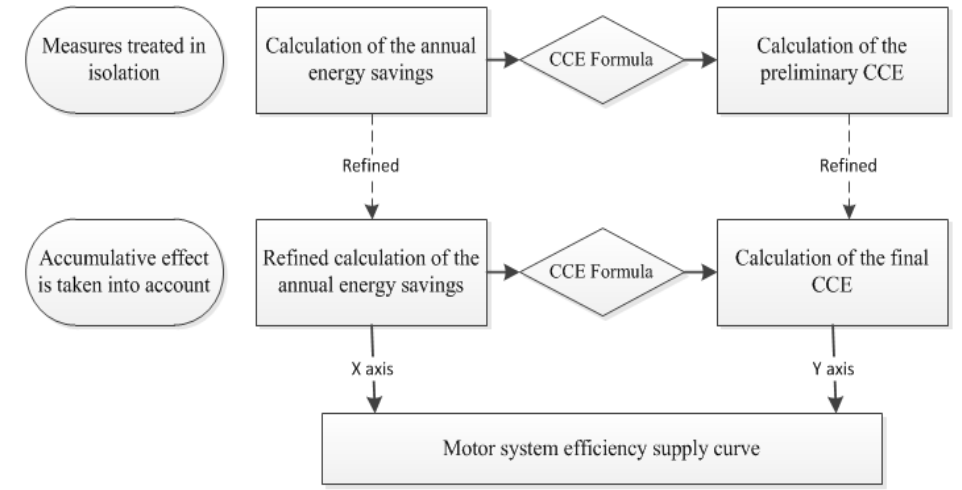
Figure 11. Procedure of the Conservation Supply Curve (CSC) calculation.